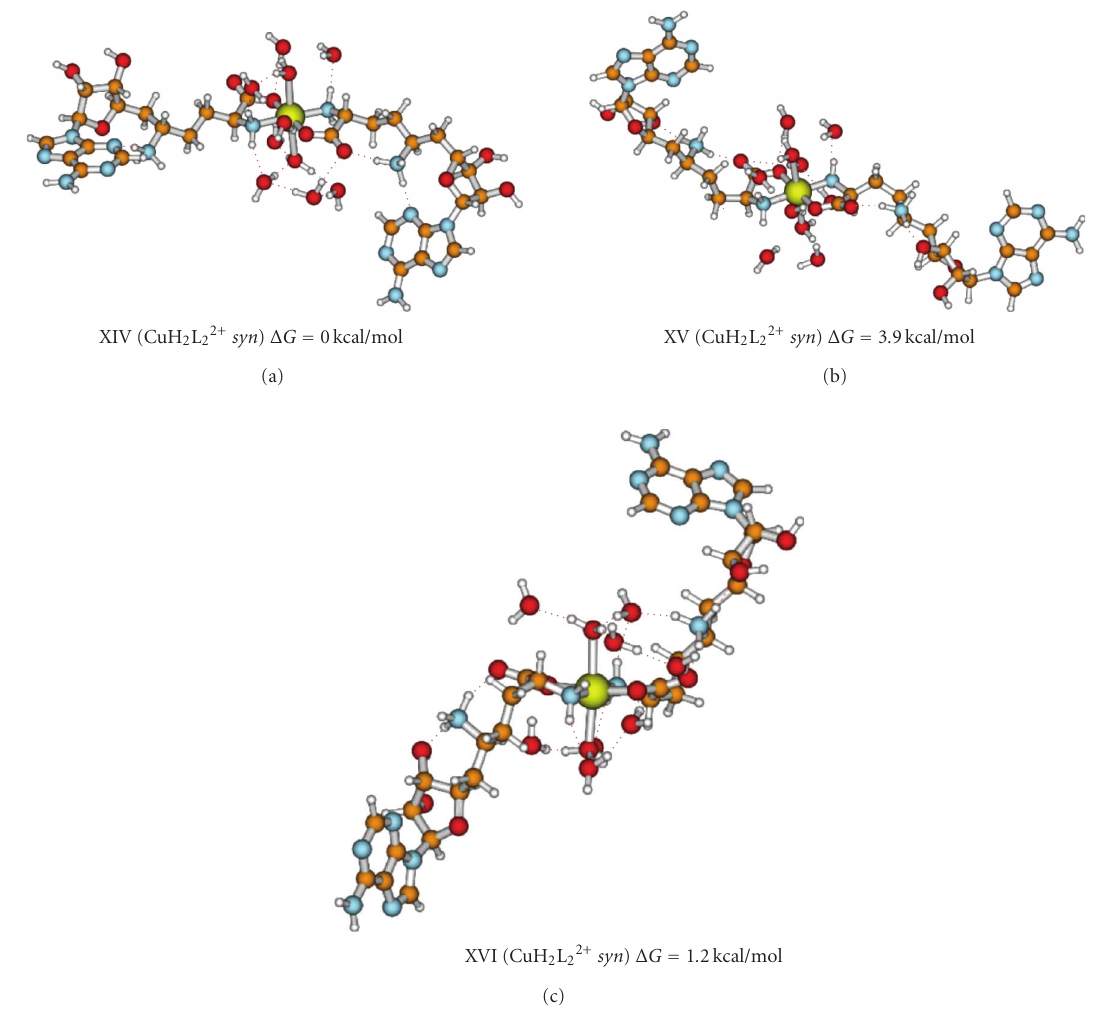
Figure 8: The lowest energy structures of CuH 2 L 22+ in syn conformation. The angle Cu–N–C–C defining the conformation of SFG at the copper center is marked with